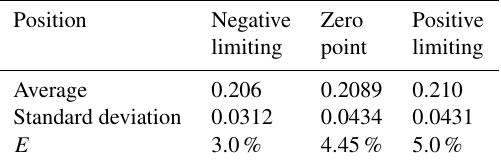
Table 3. Testing results around the Z axis (µrad).